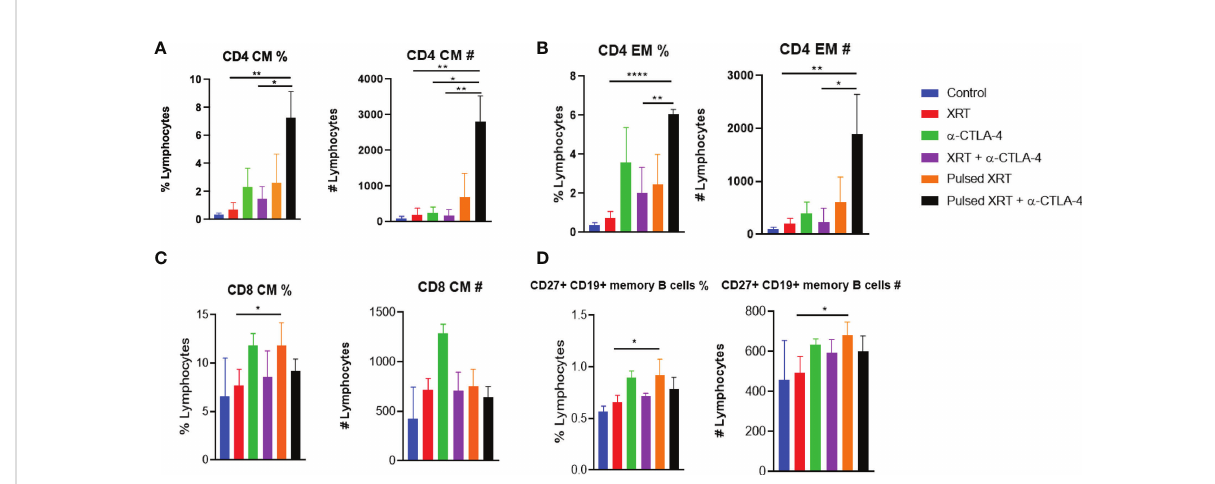
FIGURE 4 Flow cytometry analysis of lymphocytes for immune memory in the blood and spleen of treated mice on day 26. (A) CD4 + Central memory in blood as percentage and cell count. (B) CD4 + Effector memory in blood as percentage and cell count. (C) CD8 + central memory in spleen as percentage and cell count. (D) CD27 + CD19 + memory B cells in spleen as percentage and cell count. %, percentage; #, cell number; CM, Central memory; EM, Effector memory. Statistical sign fi cance was determined between two groups using Student ’ s t-test. *p < 0.05, **p < 0.01, ****p <